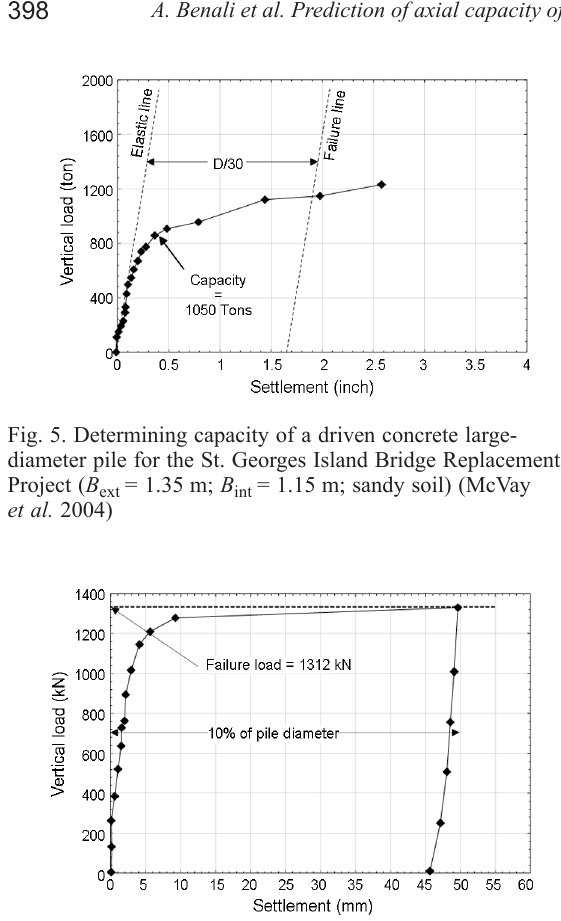
Fig. 6. Determining capacity of a driven concrete small- diameter pile ( B = 0.5 m; sandy soil) (Reiffsteck 2009)